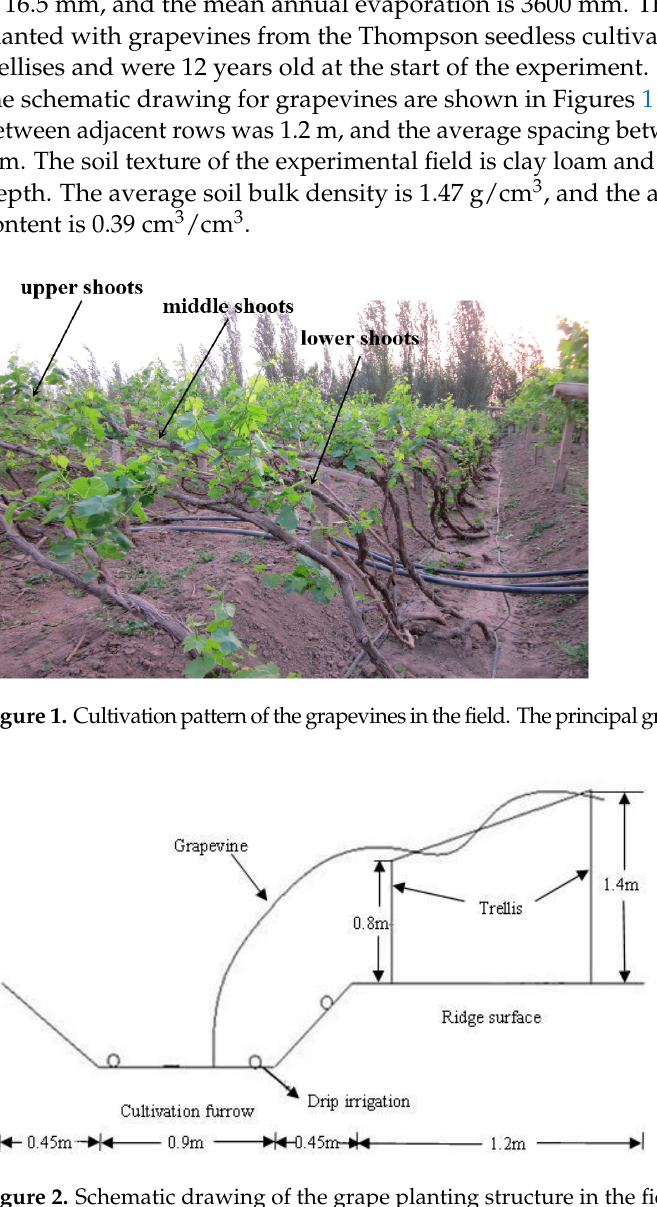
Figure 2. Schematic drawing of the grape planting structure in the field.